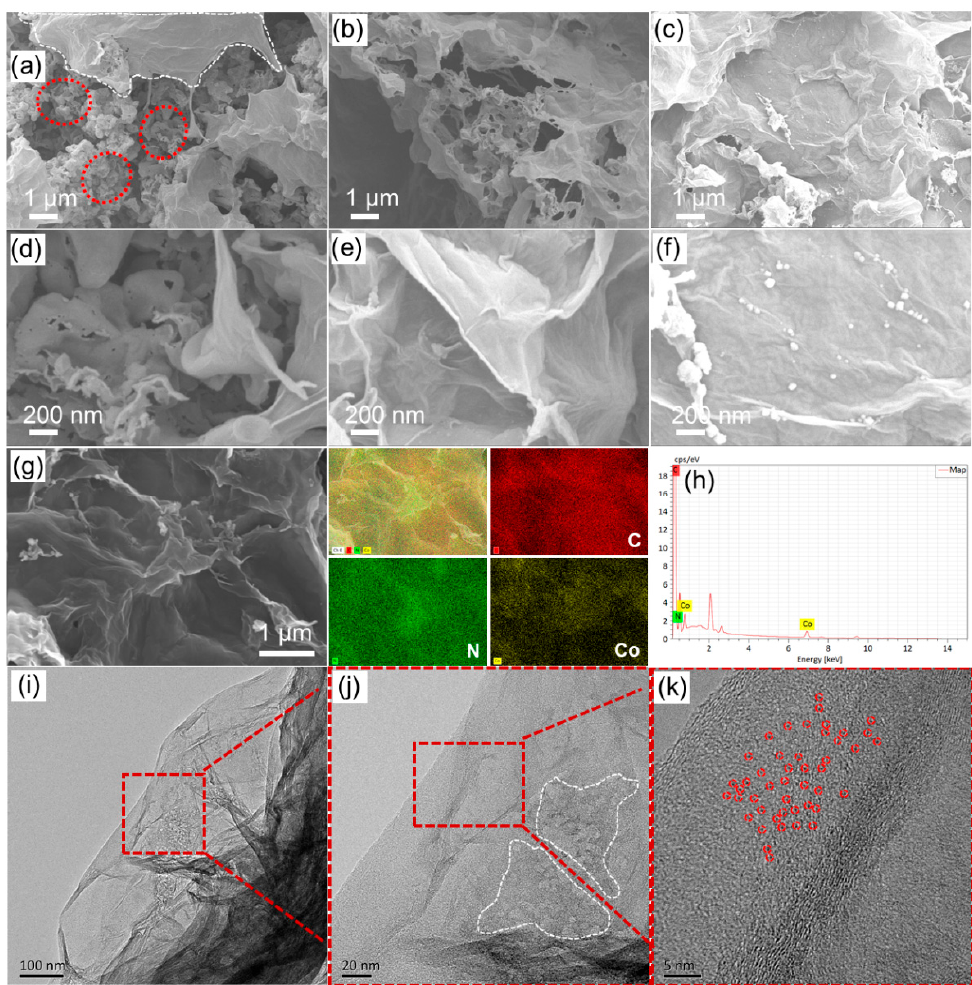
Figure 2. FE-SEM images of prepared Co@g-C 3 N 4 /G samples at different calcination temperatures: ( a,d ) 500, ( b,e ) 550, and ( c,f ) 600 ◦ C. ( g,h ) SEM mapping and EDS of Co@g-C 3 N 4 /G at 550 ◦ C. ( j ) TEM and ( i,k ) high–resolution TEM (HRTEM) images of the Co@g-C 3 N 4 /G